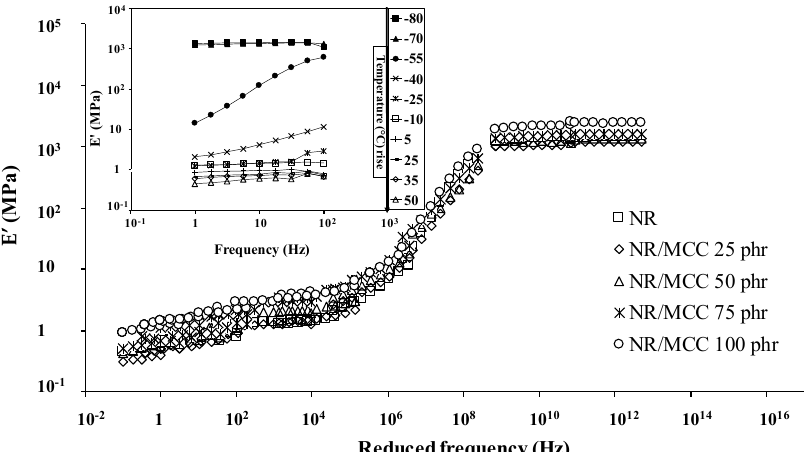
loading of filler had higher level in this rubbery plateau, indicating more relaxation time of rubber molecules.